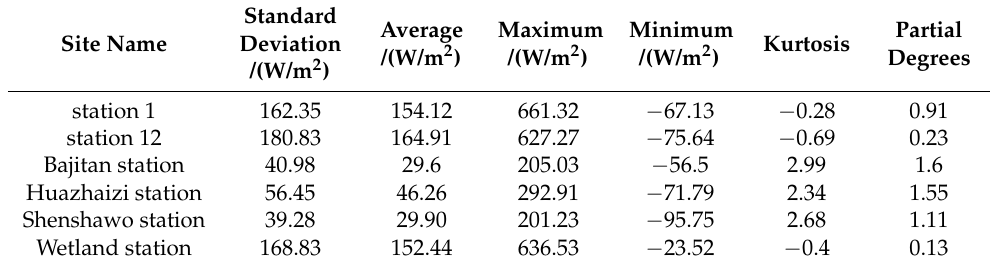
Table 2. LE statistical results of 9 days were synthesized under different types of underlying